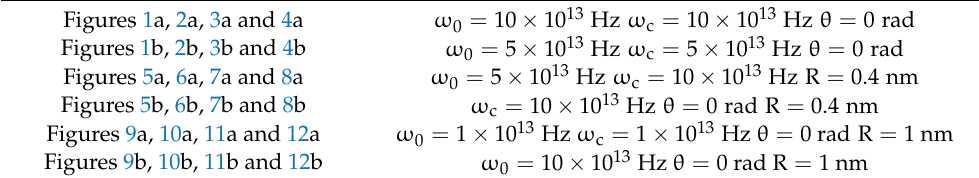
Table 2. Values of partial parameters used in